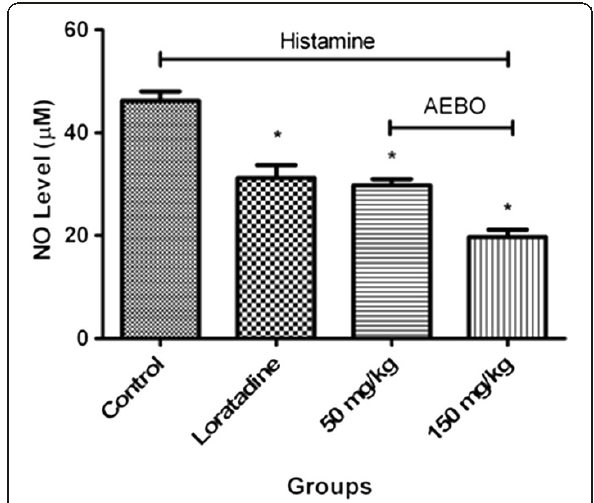
Figure 4 Effect of AEBO on histamine-induced NO production in rat ’ s paw. Paw tissue was homogenized and the supernatant was assayed by the Griess reaction. Data are presented as mean ± SEM, n = 6. * P < 0.05, significantly different from control.